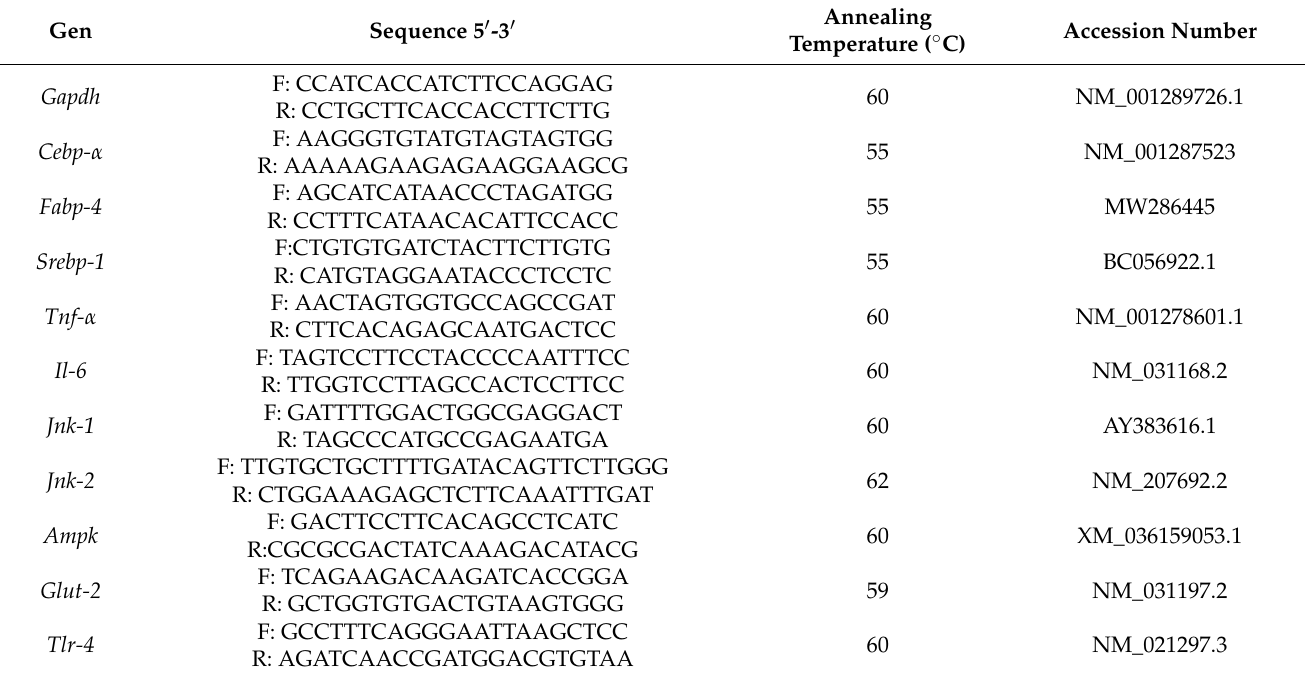
Table 1. Primer sequences used in real-time PCR